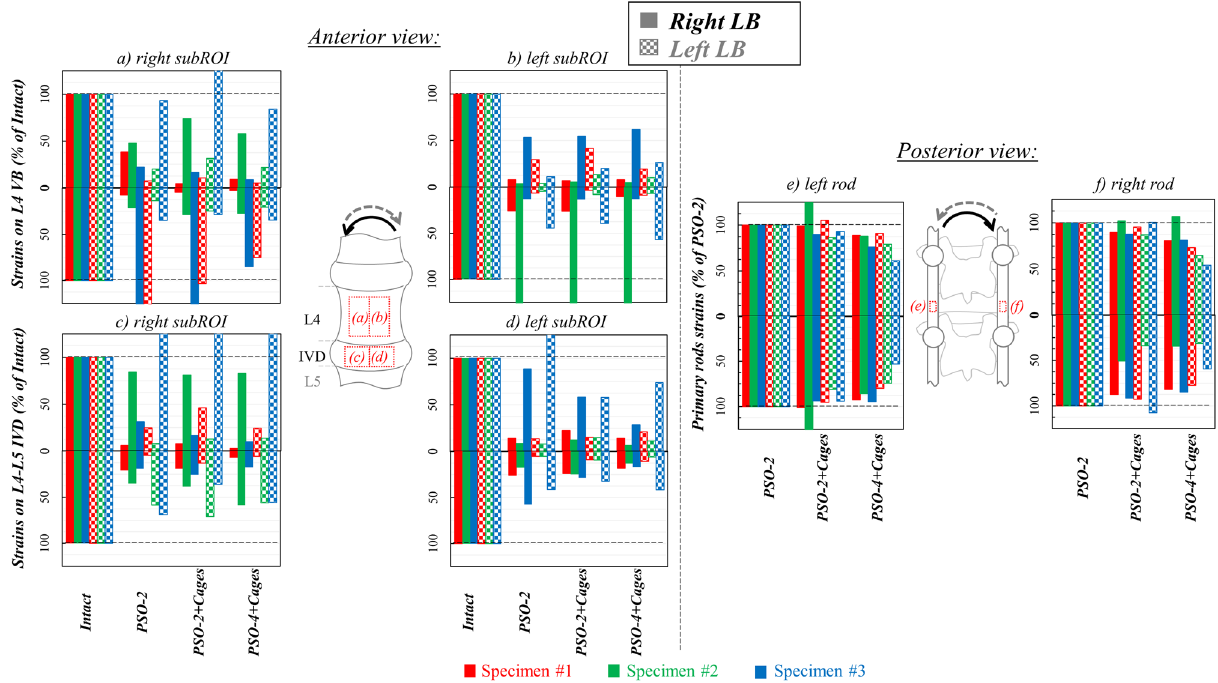
Figure 6. Lateral bending (LB): Normalized strain values on the sub-regions of interest (subROI) on L4 VB ( a right subROI; b left subROI) and on the L4-L5 IVD ( c : right subROI; d left subROI) and normalized primary rods strains both on the left ( e ) and right ( f ) rods following PSO at L4 and posterior instrumentation with 2 primary-rods (“PSO-2”), with 2 rods and supplementary intervertebral cages (“PSO-2 + Cages”) and with supplementary accessory rods and intervertebral cages (“PSO-4 + Cages”). Supplementary Tables provide quantitative strain data either for each specimen and grouped by ipsi-/contra-lateral sides both anteriorly and